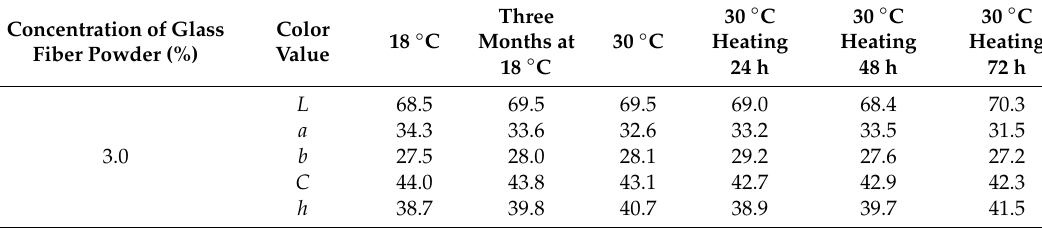
Table 9. E ff ect of time on the color values of heat preservation waterborne coatings. Concentration of